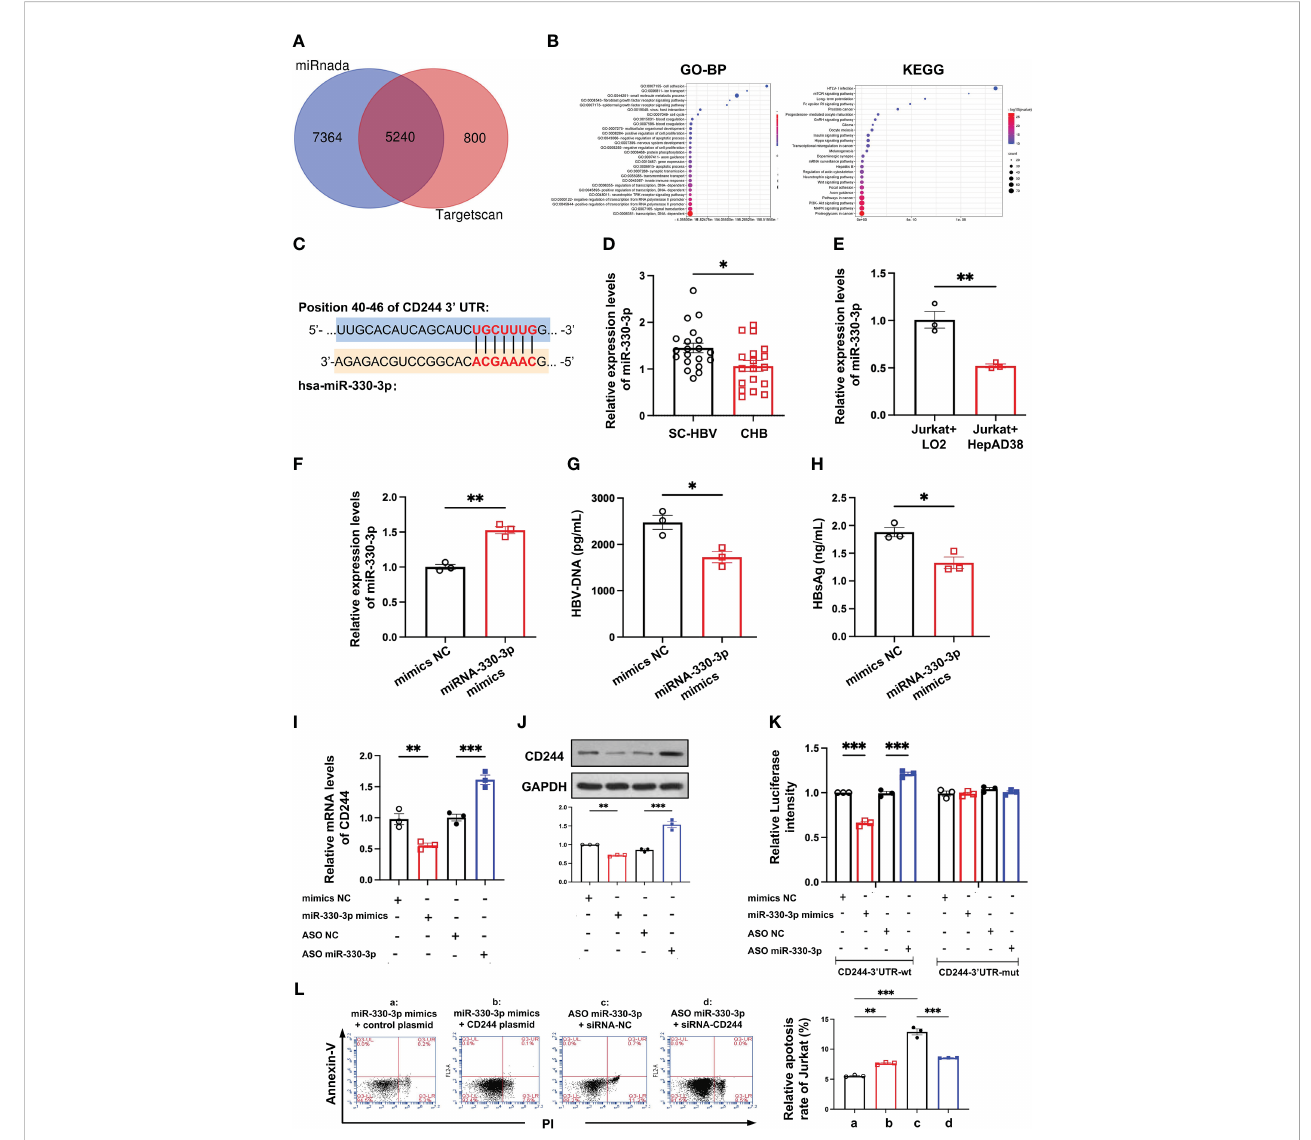
FIGURE 4 The miR-330-3p regulated immune response to HBV infection with CD244 alteration. (A) The target mRNAs predicted using the miRnada (www. microrna.org) and TargetScan (www.targetscan.org). (B) GO (biological process) and Kyoto Encyclopedia of Genes and Genomes (KEGG) pathway enrichment analysis. (C) The prediction interaction sites of CD244 and miR-330-3p. (D) RT-PCR analysis of miR-330-3p expression in CHB (n = 18) and SC HBV (n = 20) patients. (E) The expression of miR-330-3p in co-culture system of LO2 hepatocytes or HBV infected HepAD38 cells with Jurkat cells. (F-H) The alteration of miR-330-3p (F) , HBV DNA (G) , and HBsAg (H) treated with miR-330-3p mimics or negative control miRNA in the co-culture system of HepAD38 cells with Jurkat cells. (I, J) The expression of CD244 mRNA levels (I) and protein levels (J) in co-culture system after miR-330-3p mimics/ASO miR-330-3p (inhibitors) or controls transfection. (K) The relative luciferase activity in co-culture HepAD38 cells and Jurkat cells transfected with the indicated CD244-3 ’ UTR-wt plasmid or indicated CD244-3 ’ UTR-mut plasmid after the intervention of miRNA mimics/ASO miR-330-3p or not. (L) The rescue effect of siRNA-CD244 on the inhibition of apoptosis of Jurkat cells, inducing by CD244 plasmid or ASO miR-330-3p, by fl ow cytometry staining with Annexin V/PI. Data (n = 3 per group) were expressed as mean ± SEM and analyzed using Student t test or two-way analysis with Turkey ’ s multiple comparisons test, * P < 0.05, ** P < 0.01, *** P <